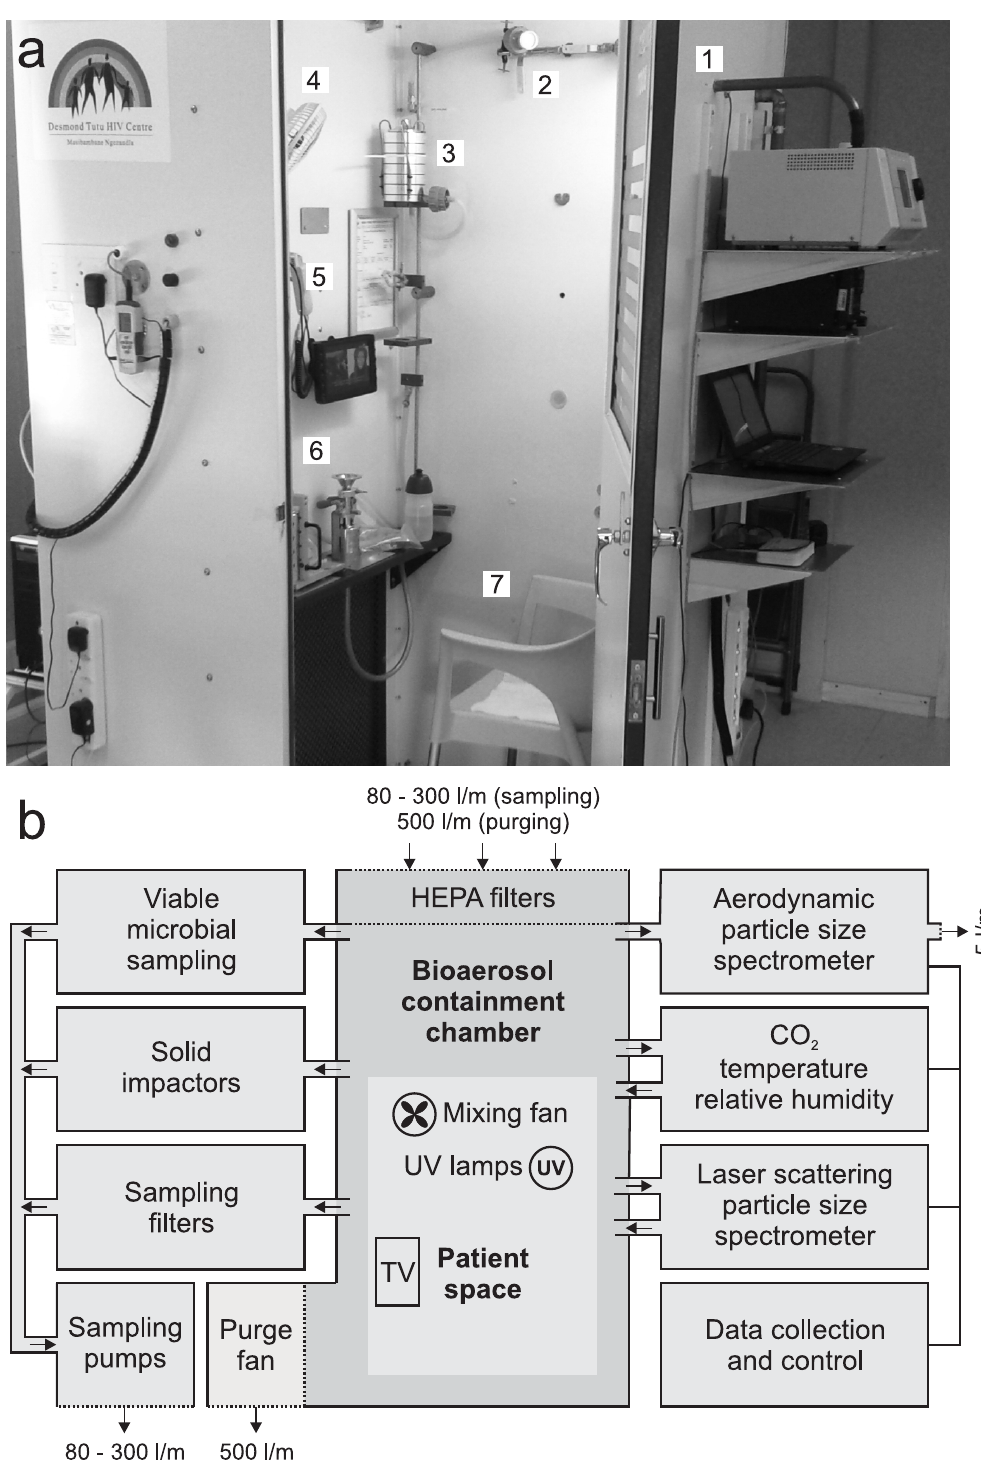
Fig 1. The Respiratory Aerosol Sampling Chamber (RASC). (A) Photograph of the RASC (with the door open) on site in a community TB clinic (1) aerodynamic particle sizer (2) Filter samplers (3) Andersen impactor (4) Mixing fan (5) CO2, temperature and RH (6) PM10 impactor (7) Chair for participant. (B) Block diagram depicting the fluidic and electronic configuration of the RASC. Thick connecting lines indicate airflow and aerosol paths; thin lines indicate electronic connections. All air leaving the RASC is HEPA filtered.